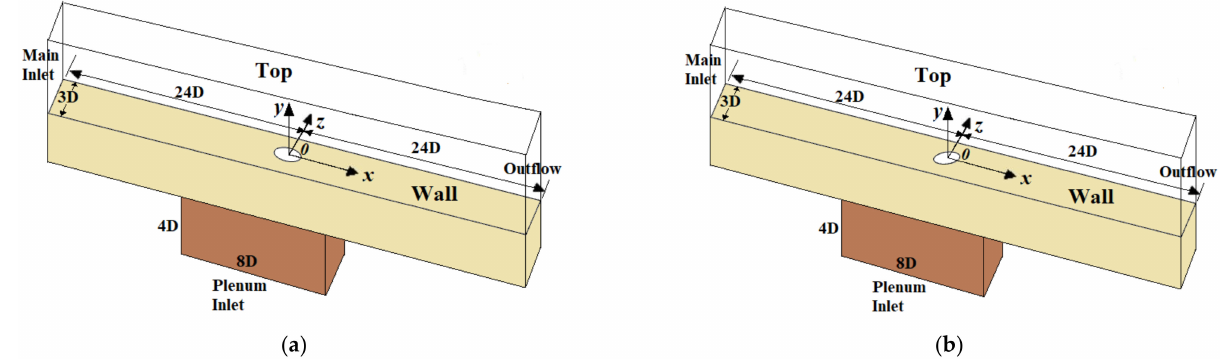
Figure 2. Computational domain configuration. ( a ) Cylindrical hole, β = 0 ◦ ; ( b ) Cylindrical hole, β = 30 ◦ .